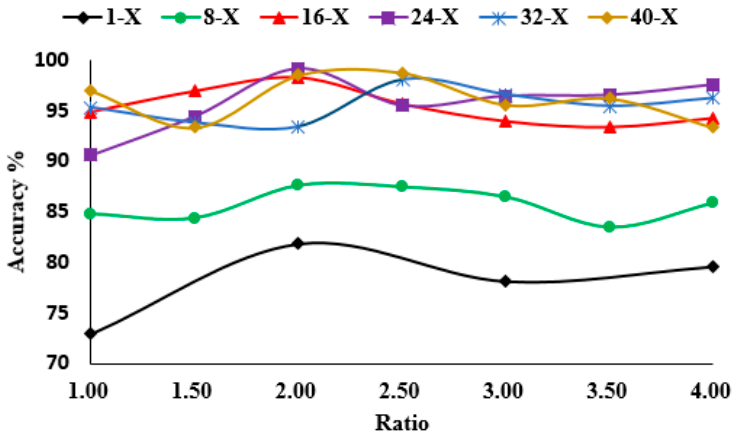
ff erent ratios.